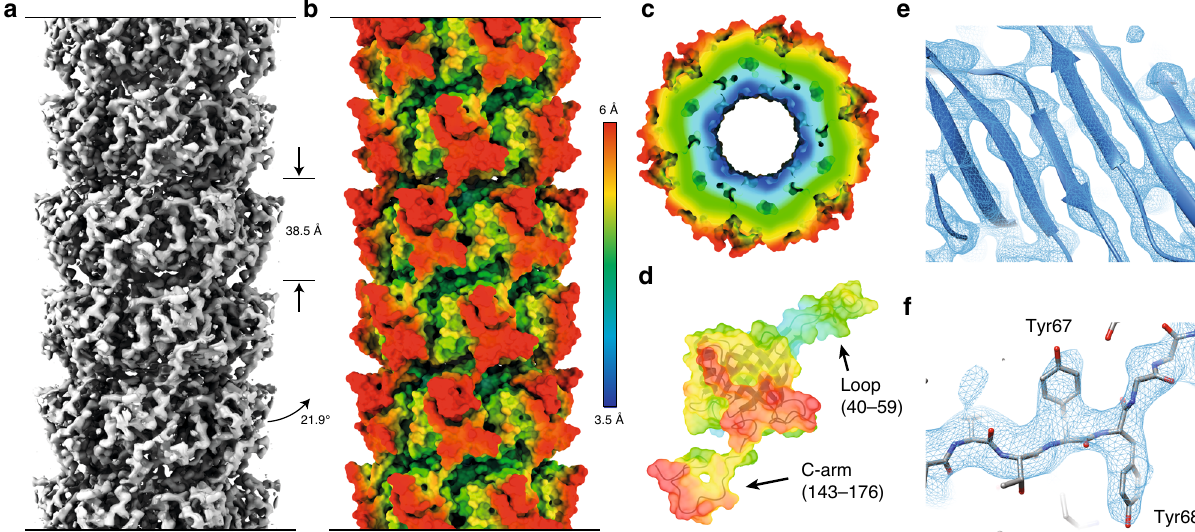
Fig. 2 Cryo-EM data for hybrid structure calculation provides global and local information. a 3.5 – 6Å cryo-EM map of the tail tube of SPP1 consisting of polymerized gp17.1 subunits does not only allow to deduce symmetry restraints but also limits the position of all atoms within the density. Rings with a thickness of 38.5Å (as represented by the straight arrows) stack onto each other with a rotation of 21.9° (as represented by the bent arrow). b – d Local resolution of the cryo- EM map increases going from outer to the inner surface of the tail tube (as represented by the color gradient). e The inner region of the map reveals a highly resolved β -barrel and allows for the positioning of bulky sidechains as exempli fi ed for Tyr67 and Tyr68 ( f ). The direction of the tail structure is baseplate